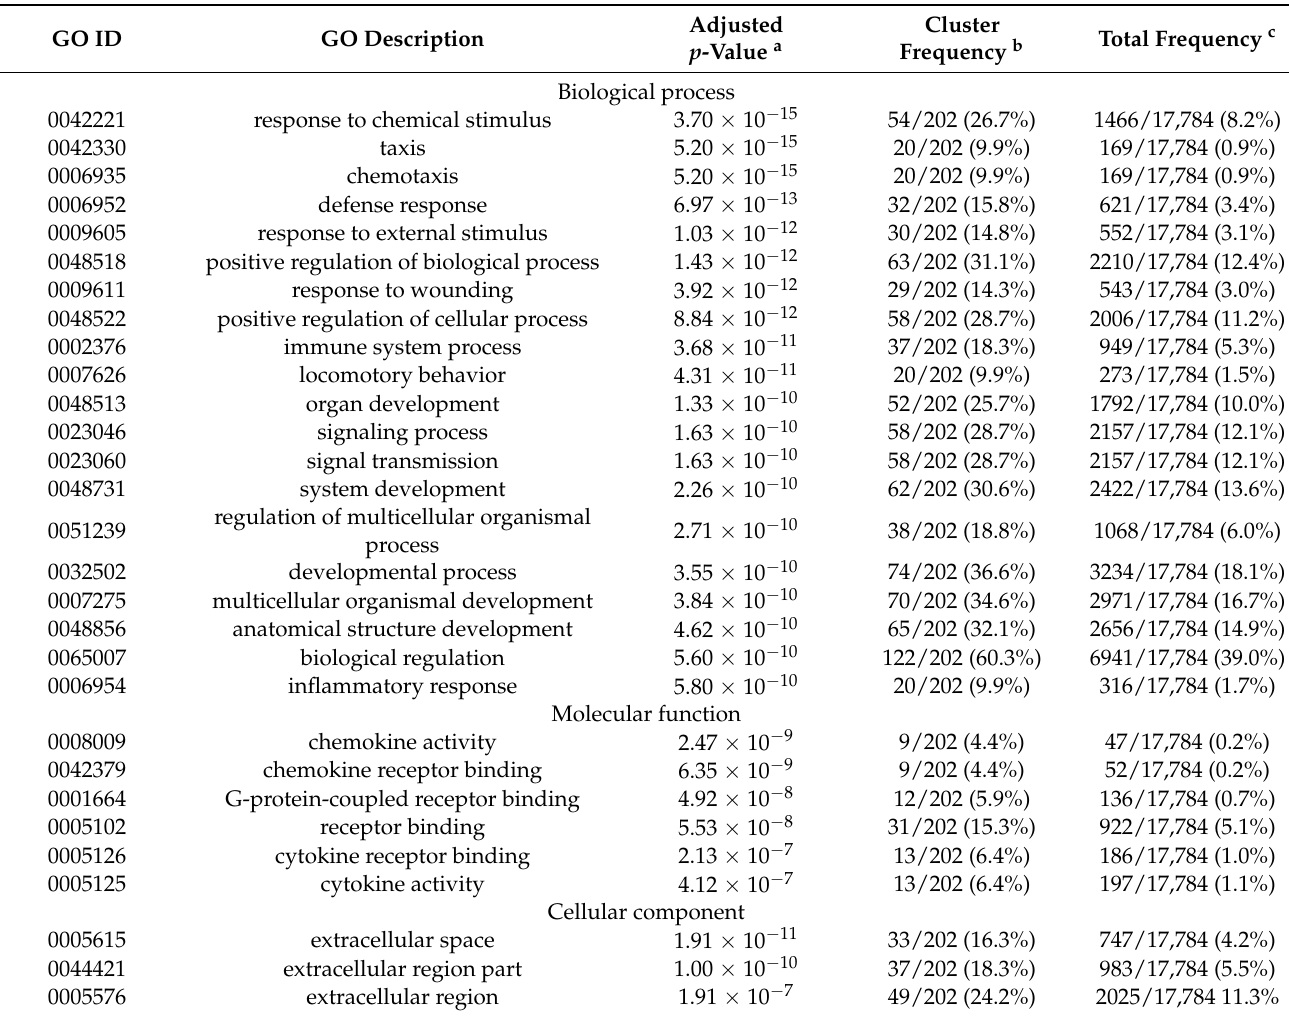
Table 1. Gene ontology (GO) enrichment analysis of differentially expressed genes in Caco-2 cells stimulated with